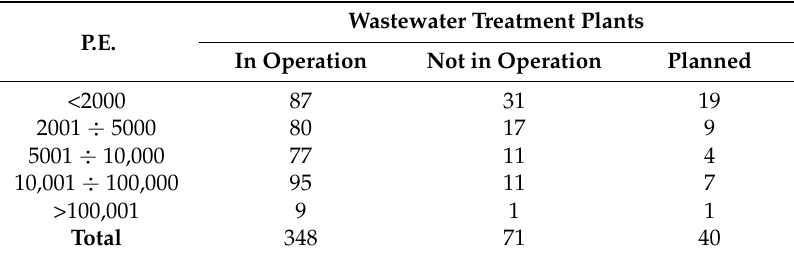
Table 1. Classes of WWTPs for P.E.